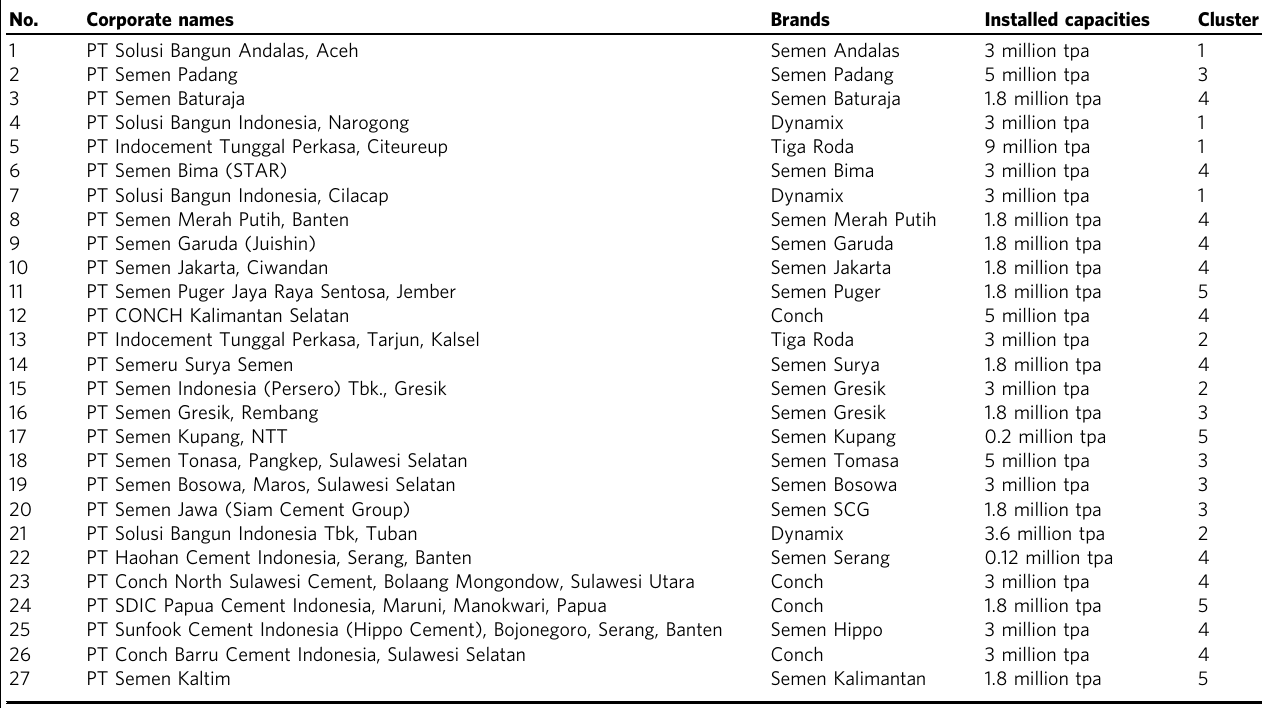
Table 1 Clusterisation of cement makers in Indonesia.